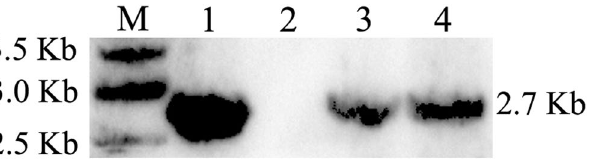
Figure 4. Analysis of transgene integration in the cloned calf by Southern blot. Lane M: molecular size markers (1-kb ladder, Invitrogen); Lane 1: positive control; Lane 2: non-transgenic cells; Lane 3: transgenic cells; Lane 4: cells from the ear tissue of transgenic cloned